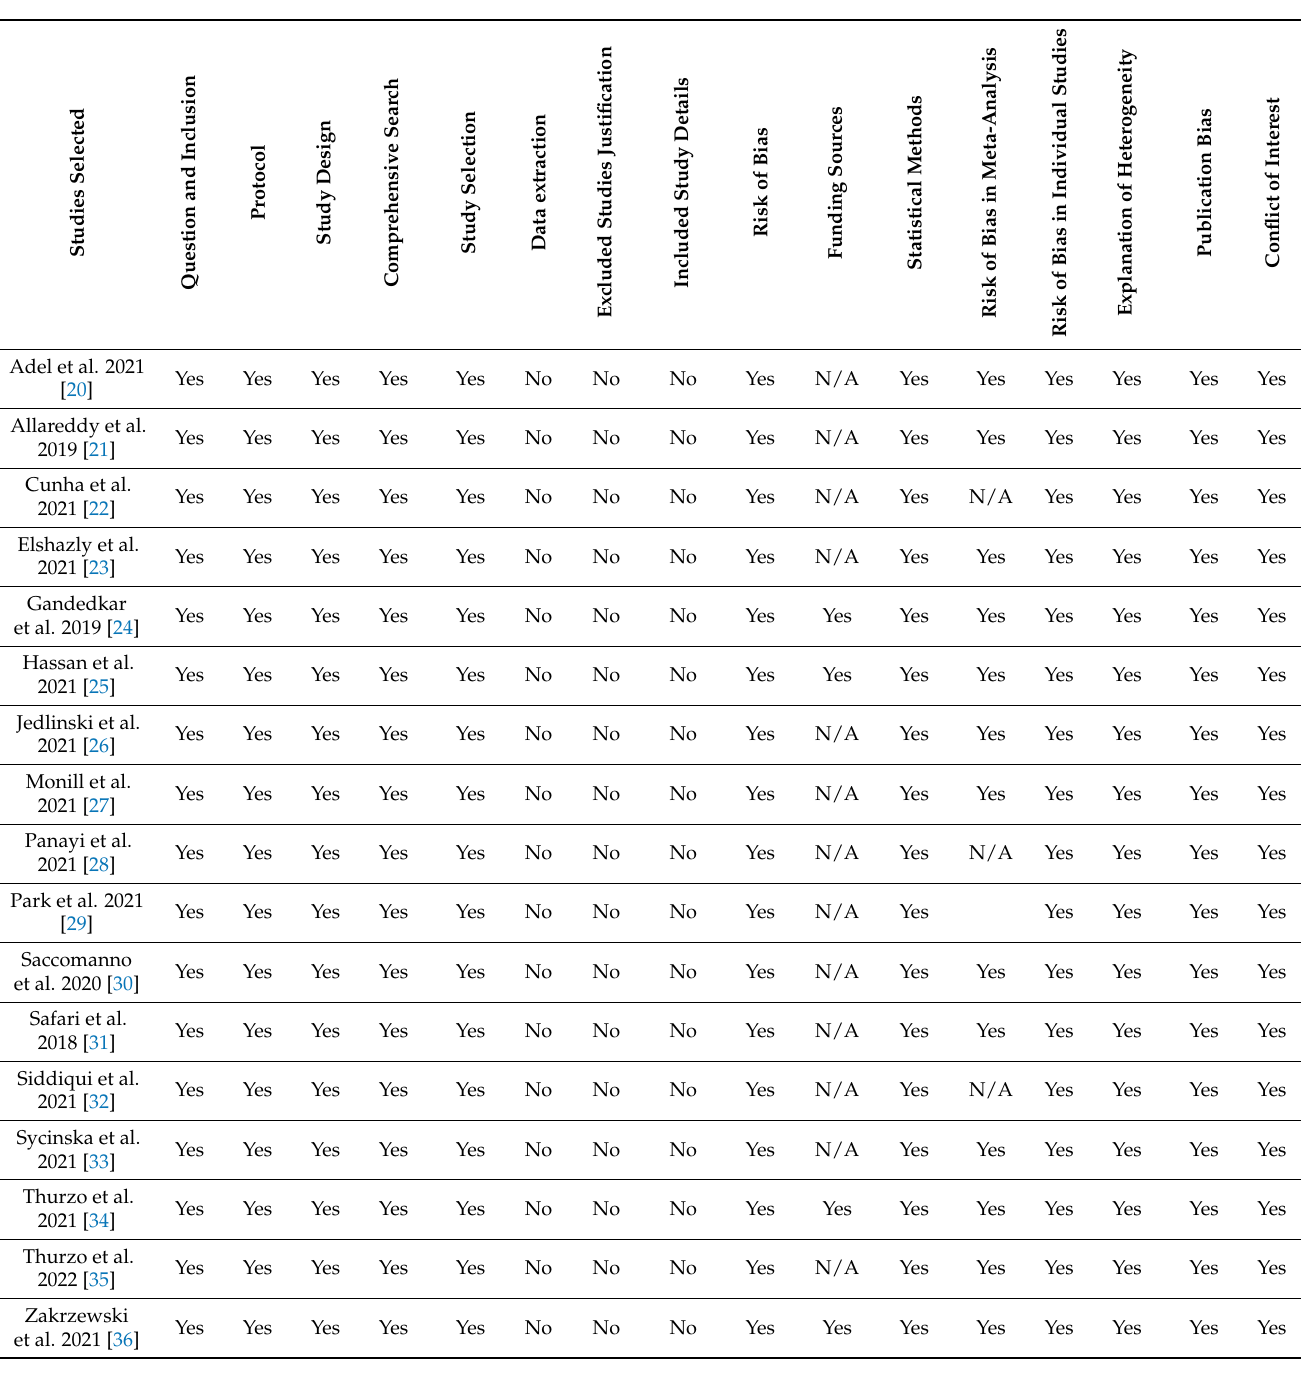
Table 1. AMSTAR-2 16-point checklist of risk of bias assessment in studies selected for the system- atic